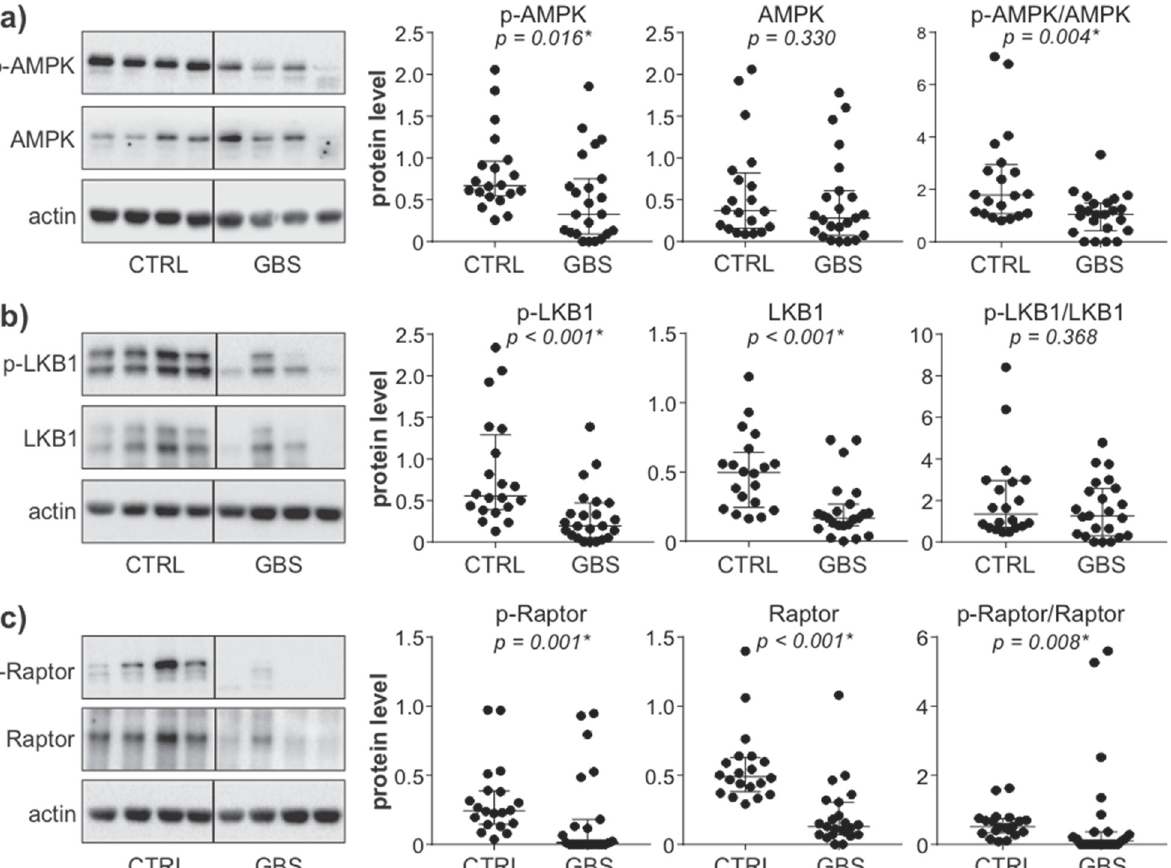
Figure 1. Downregulation of AMPK signaling in the PBMCs of GBS patients. ( a – c ) PBMCs were isolated from control subjects (CTRL; n = 20) and GBS patients ( n = 23), and the levels of phosphor- ylated and total forms of AMPK ( a ), LKB1 ( b ), and Raptor ( c ) were analyzed by immunoblotting. The representative blots are shown, while densitometry results are presented relative to actin or as phospho/total signal ratio (horizontal lines represent median and interquartile range; * p < 0.05, two- tailed Mann–Whitney U test).